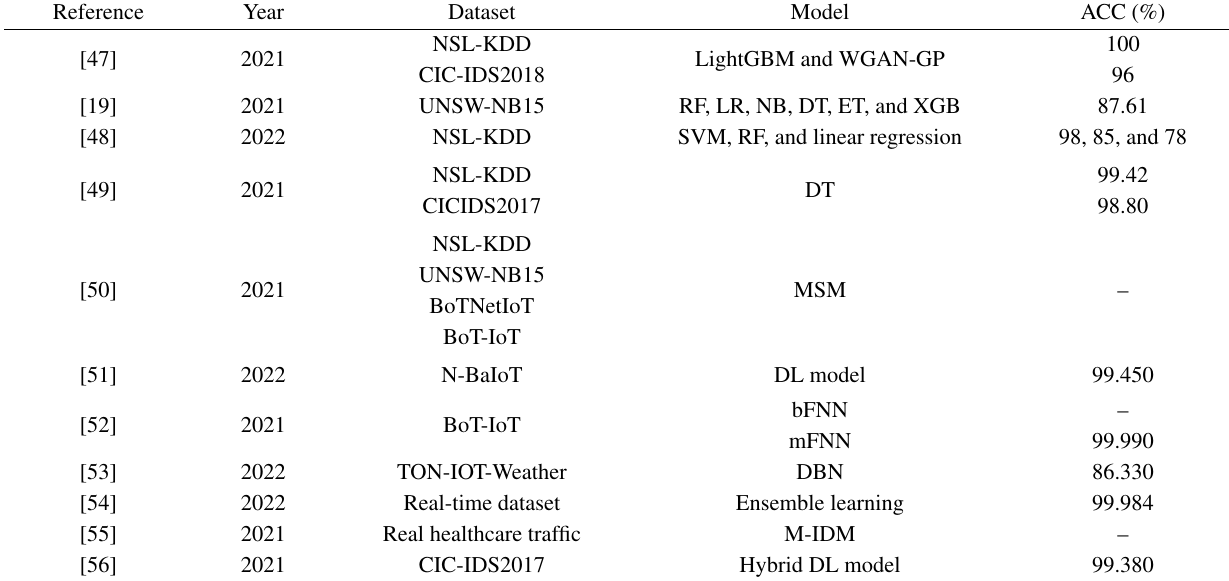
Table 1 A summary table of different